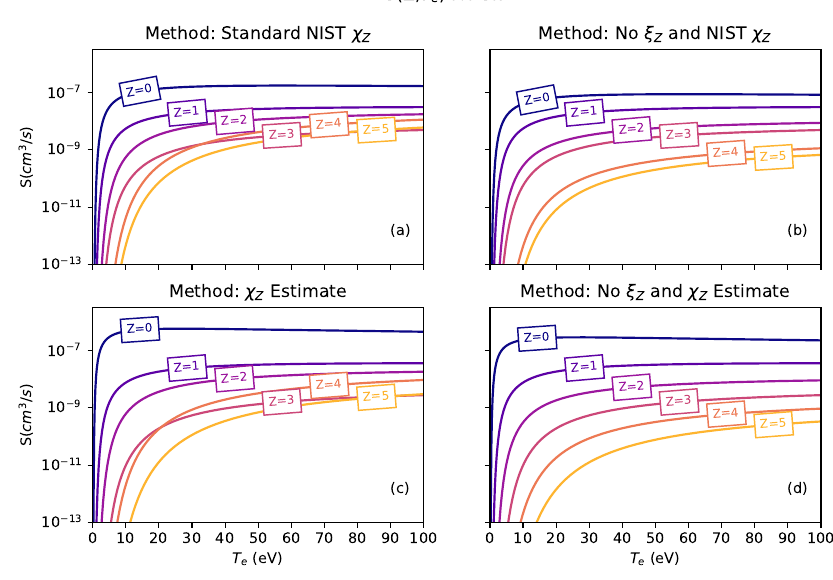
Figure 3. Plots of the collisional ionization rate coefficient for neutral Sn to Sn 5 + . Each plot was made using Equation (4) without any changes with the NIST χ ξ ( b ), with the estimated ionization energies from Equation (7) ( c ), and with the estimated ionization Z energies and without ξ ( d Z